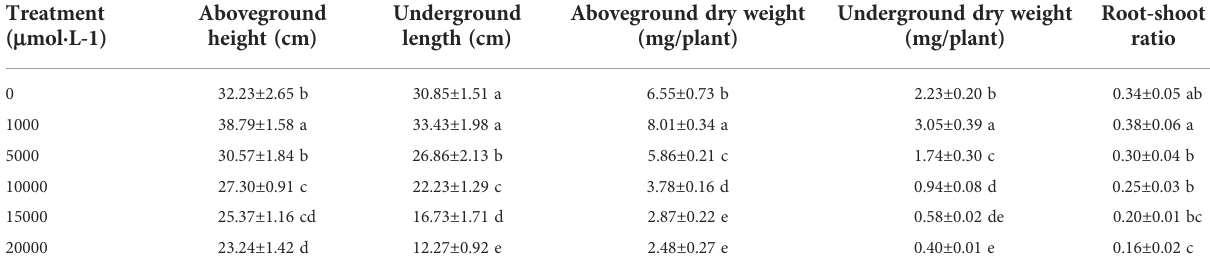
TABLE 1 Effects of manganese stress on plant growth of D.